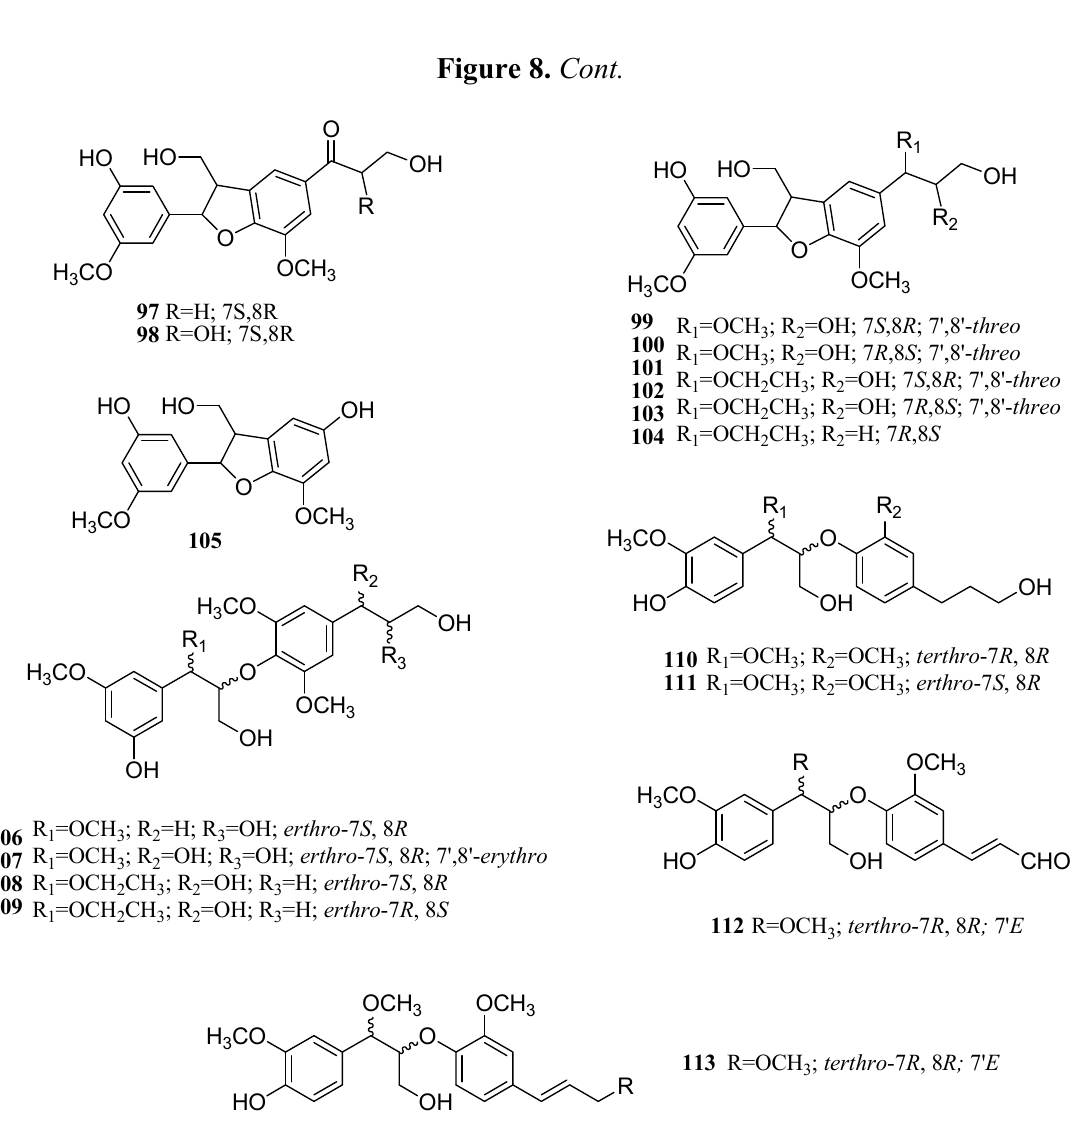
Figure 9. Chemical structures of hydroxycinnamic acids in C. pinnatifida